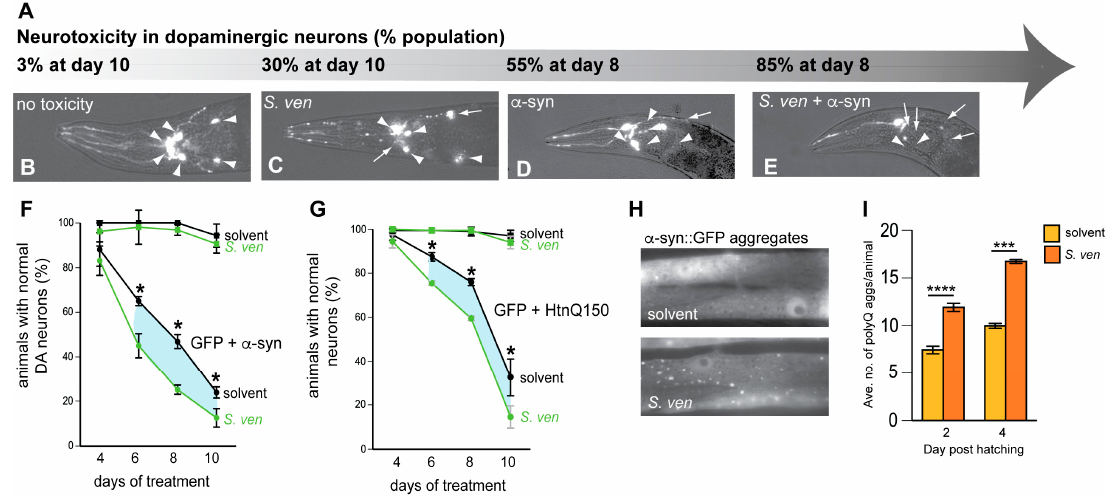
Figure 2. Gene-by-environment interactions exacerbate C. elegans phenotypes. ( A – E ) Genetic or environmental factors can be rapidly quantified for degenerative phenotypes by examining the six anterior dopaminergic neurons of C. elegans . Since the majority of cases of sporadic Parkinson’s disease (PD) are idiopathic, undefined factors from the environment and innate genetics that sensitize individuals to PD, or combinations thereof, could lower the threshold for neurodegeneration. Using C. elegans , the impact of both genetic and environmental exposure can be evaluated for neurotoxicity in the isogenic lines of animals for additive or synergistic effects, depending on the dosage or age of animals. ( A ) Animals displaying dopaminergic neurodegeneration can be modulated based on a causative factor; ( B ) Normal C. elegans rarely show dopaminergic neurodegeneration, even as animals reach old age (Day 10). Arrowheads indicate intact DA neurons; ( C ) The addition of the S. ven metabolite induces the age-dependent accumulation of degenerative phenotypes (arrows) and can be visualized as neuronal loss and blebbing; S. ven metabolite treatment alone results in ~30% neurodegeneration in contrast to animals overexpressing α -syn in the absence of S. ven exposure; ( D ) S. ven exposure in combination with a PD genetic factor, human α -synuclein ( α -syn) overexpression is additive; ( E ) Whereby ~85% of the population displays neurodegeneration. Exposure to other reactive oxygen species (ROS)-inducing chemicals (i.e., 6-OHDA, rotenone, paraquat) can produce similar phenotypes; ( F , G ) S. ven exposure has been examined in combination with genetic susceptibility factors to uncover gene and environment interactions. In these scenarios, C. elegans with and without the expression of different heterologous aggregation-prone proteins were examined for neurotoxicity following exposure to metabolites. It should be noted that the concentration of metabolites that was used was much lower, since we wanted to ensure that, on its own, metabolite would not cause neurodegeneration, yet would reveal potential neurodegeneration in combination with α -syn [51]. The results shown here displayed this concept with either α -syn expressed in dopaminergic neurons; ( F ) or mutant huntingtin (Htn Q150 ) expressed in the C. elegans ASH-sensory neuron; ( G ) As shown; ( H ) The metabolite also induces α -syn-dependent proteostasis disruption in the readily visualized body wall muscle cells that express α -syn::GFP under control of a body wall muscle promoter (P unc- 54 ), and were treated with S. ven metabolite continuously since hatching; ( I ) C. elegans expressing a nucleotide repeat encoding 35 polyglutatmines (Q35) in body wall muscles (P unc- 54 ::polyQ35::GFP) that were exposed to the metabolite display an increase in aggregate number compared to solvent [51].